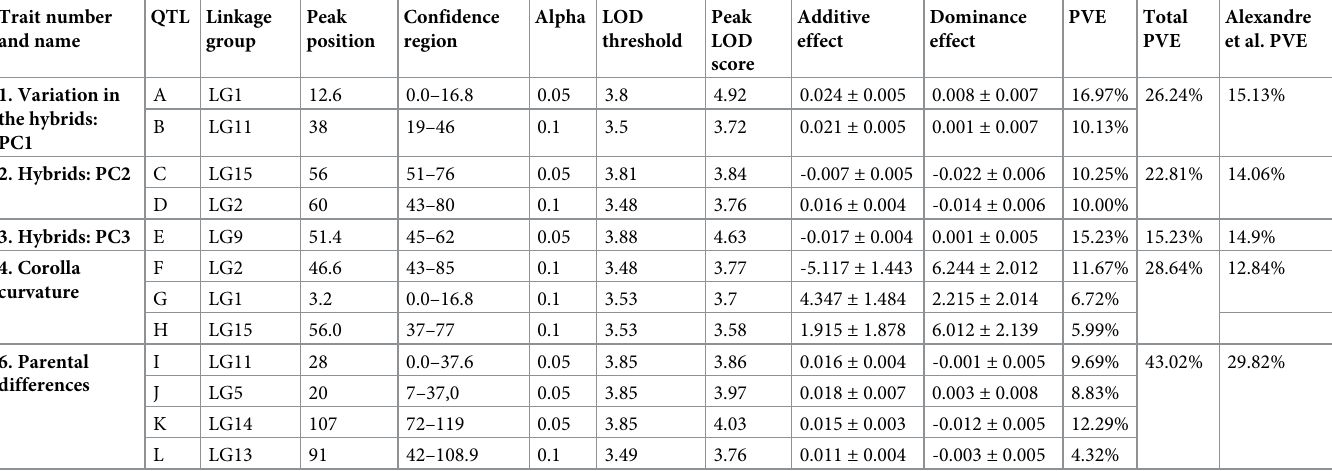
The letters attributed to each QTL for identification purposes are illustrated in Fig 5. Positions of confidence intervals (1.5 LOD score decrease) are given in centimorgan (cM) from the beginning of the linkage group. Alpha indicates the significance threshold at which the QTL was significant. PVE stands for the proportion of variance explained. Trait 5 did not result in any